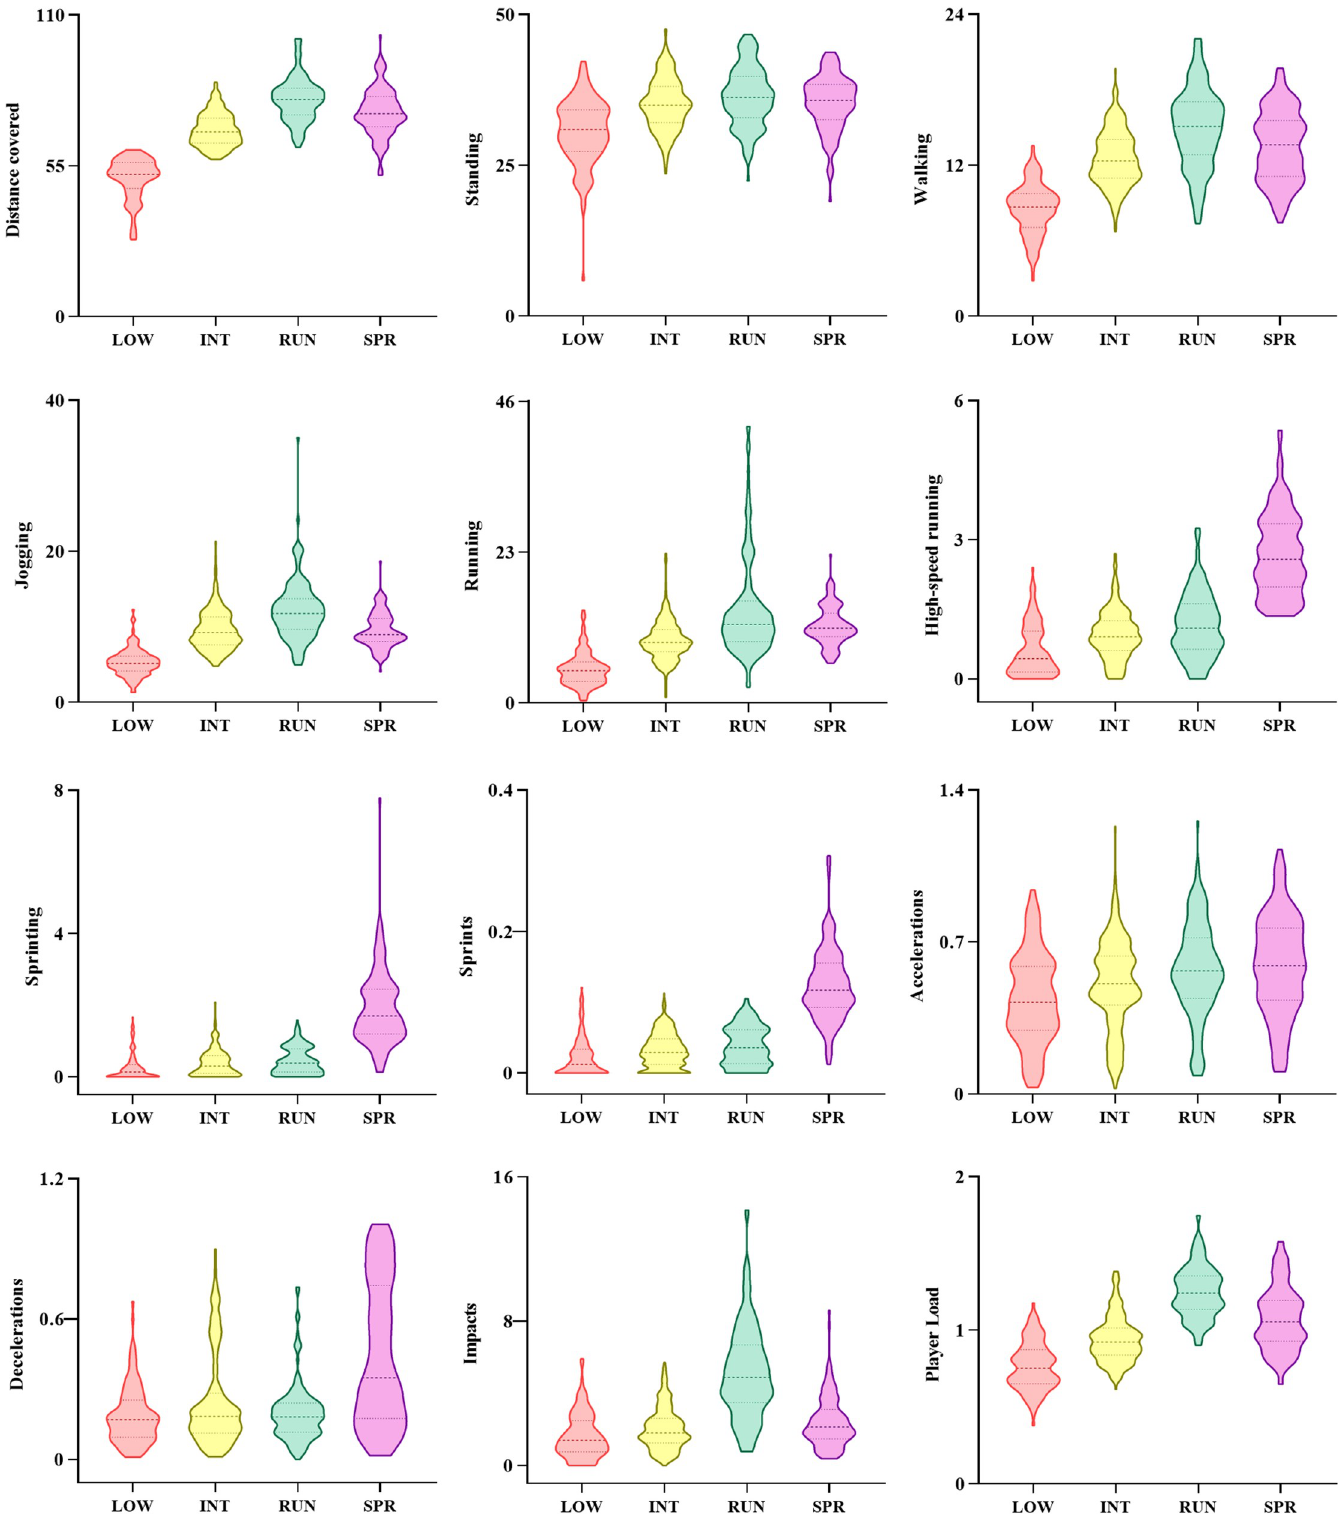
Fig 3. Violin plots showing the distribution of the training variables according to the clusters obtained. The violin plots indicate the data distribution, the median and the 1 st quartile (25 th percentile) and the 3 rd quartile (75 th percentile), for each group. LOW = lower-demand sessions; INT = intermediate-demand sessions; RUN = running-based sessions; SPR = sprint-based